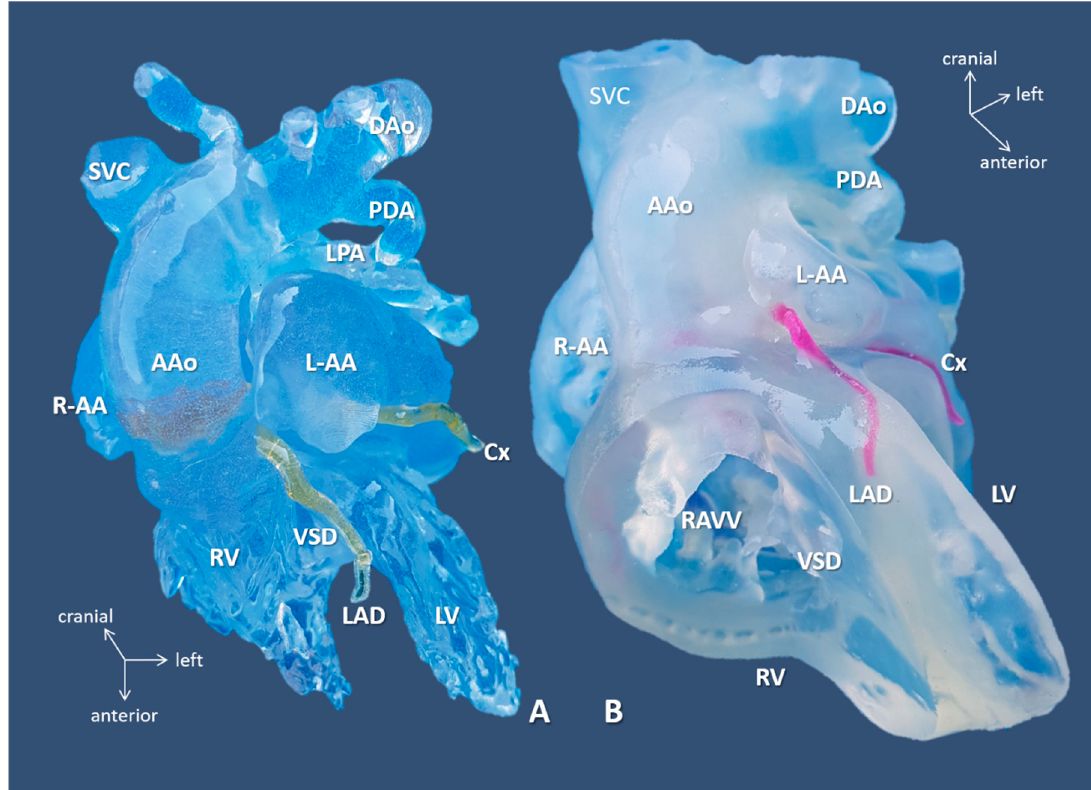
Figure 4. 3D-printed blood volume ( A ) and hollow ( B ) models of right atrial isomerism, visceral heterotaxy, and dextrocardia (Case 10). Anterior view: free wall of the ventricles is removed on the hollow model. Complex anomalies comprised of left-sided IVC; right-sided SVC receives inflow from common pulmonary vein, i.e., supracardiac total anomalous pulmonary venous return (see, below); common atrium, complete AV defect; double outlet right ventricle/transposition of the great arteries with pulmonary atresia. 3D-printed models were instrumental in planning for complete biventricular repair the patient successfully underwent subsequently. Abbreviations: AAo: ascending aorta, Cx: circumflex coronary artery, DAo: descending aorta, L-AA: left-sided morphologically right atrial appendage, LPA: left pulmonary artery, LV: left ventricle, PDA: patent arterial duct, R-AA: right-sided morphologically right atrial appendage, RAVV: right AV valve, RV: right ventricle, SVC: right-sided superior vena cava, VSD: ventricular septal defect.